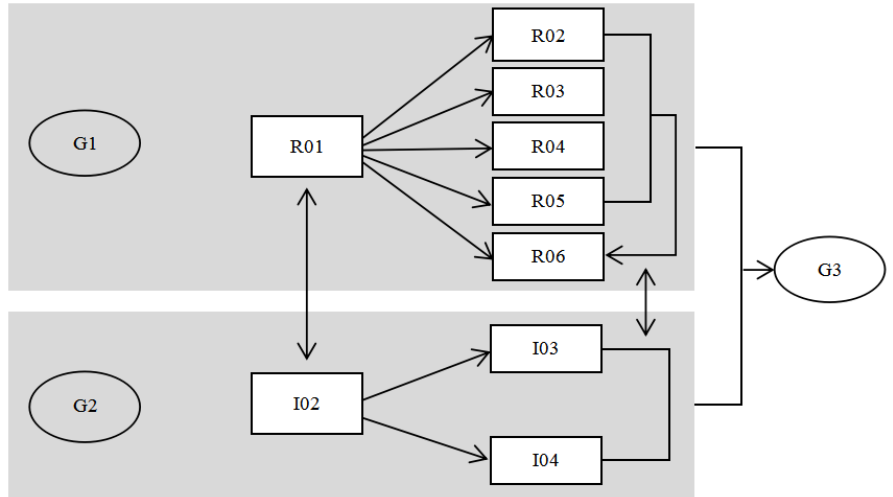
Figure 5. Participants in the second cycle.